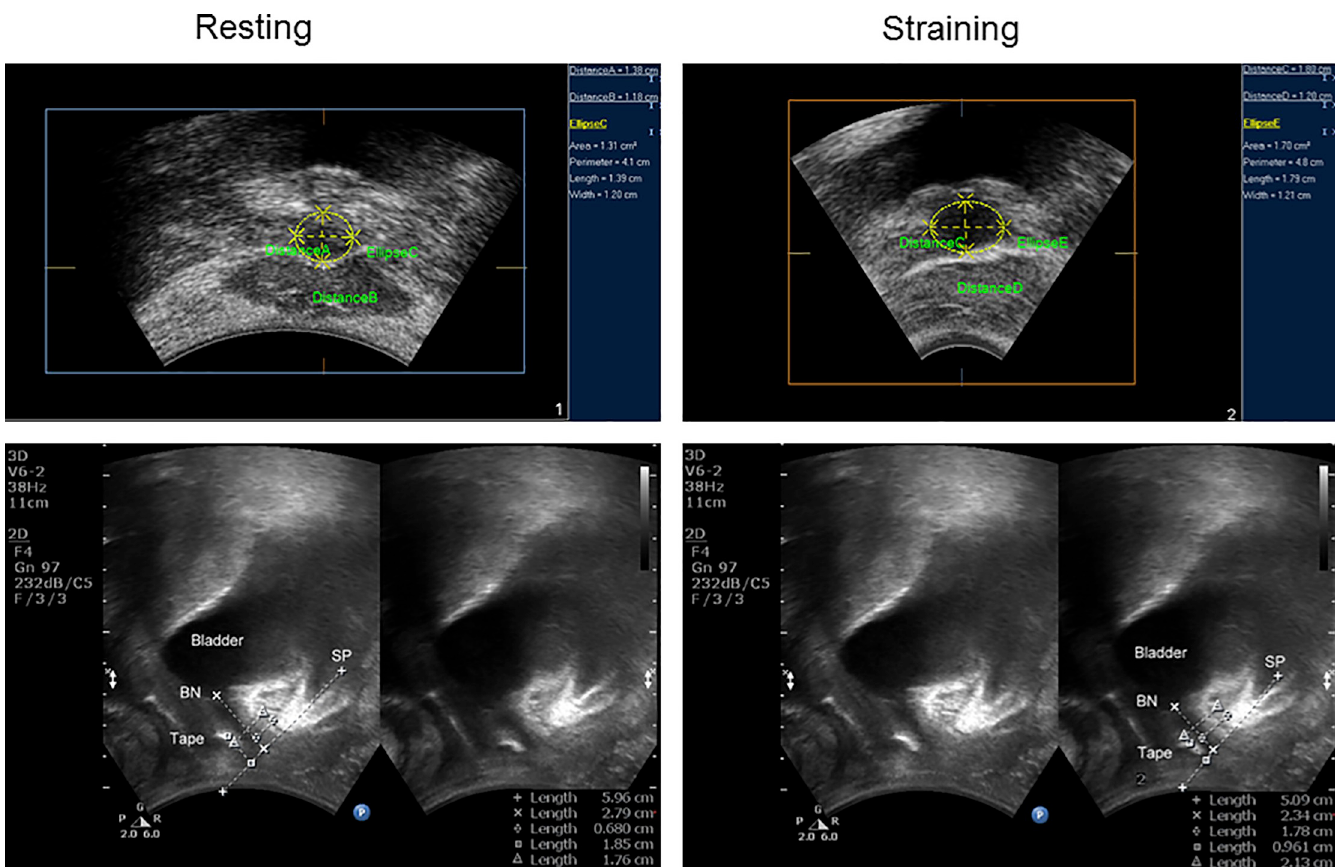
Fig 1. 3D and 2D introital ultrasound imaging revealing the lower urinary tract and mid-urethral sling during rest and straining; BN, bladder neck; SP, Symphysis Pubis.